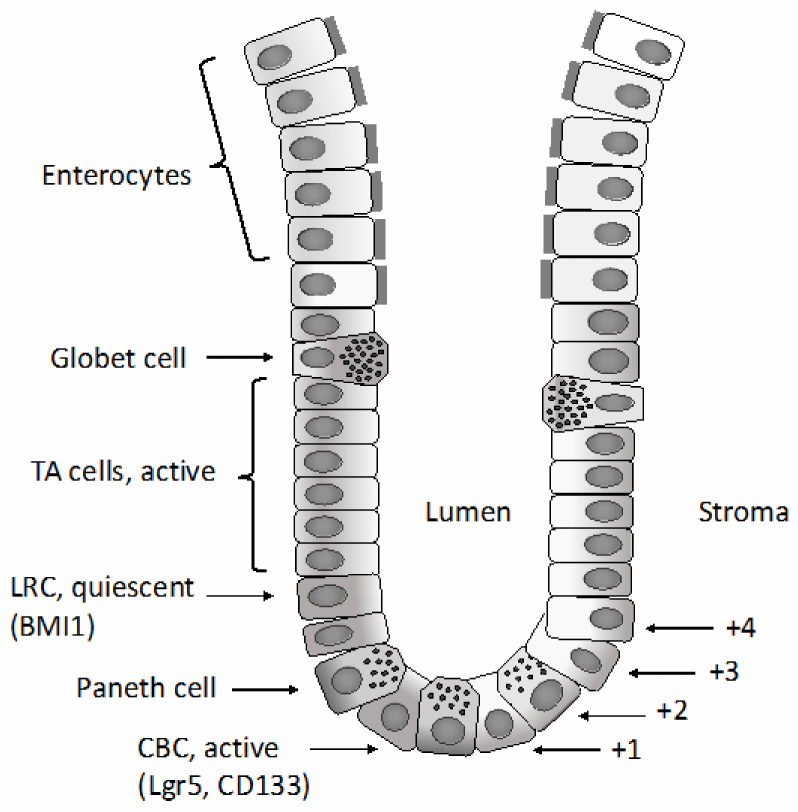
Figure 1. Schematic representation of the large intestine crypt. Each crypt comprises a bottom region, containing crypt base columnar (CBC) cells. These cells are intestinal cycling stem cells, leucine-rich repeat-containing G-protein coupled receptor 5 (LGR5) + and generate all major intestinal lineages, including secretory cells and enterocytes. Crypts also contain Paneth cells, the only mature cells that do not migrate upwards and that remain at the base of crypts, near to LGR5 + cells. The +4 region contains a population of quiescent stem cells, identified as Bmi1, LRIG1 or label-retaining cells (LRC). A transit-amplifying (TA) region contains differentiating progenitors/precursors. A top region, corresponding to the tip of villi, contains mature elements (enterocytes, goblet cells, Tuft cells and enteroendocrine